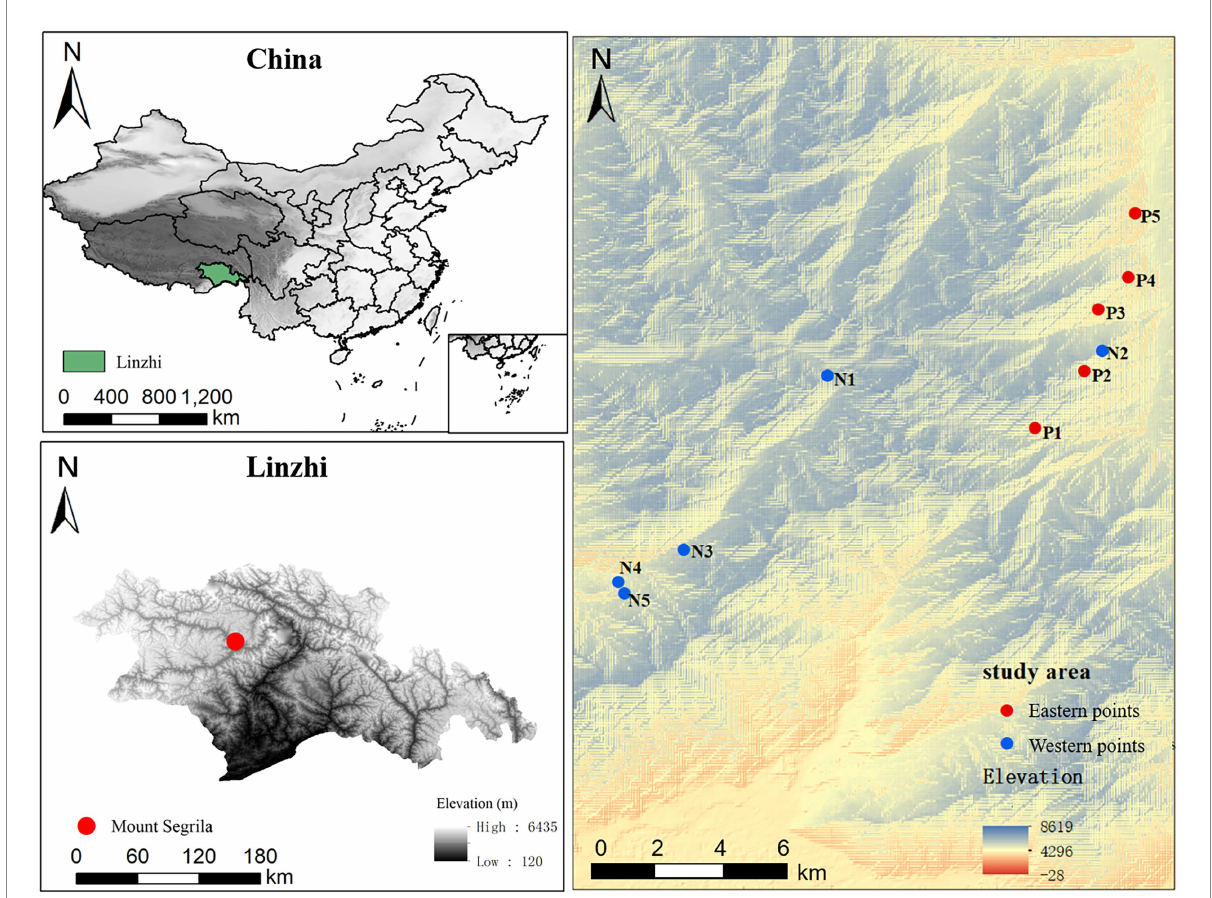
FIGURE 1 A map of the investigated area showing the locations of sampling sites along the altitudinal gradient on Mount Segrila, Tibet, China. P and N represent east slope and west slope, respectively. Different numbers mean different elevations (Number 1, 2, 3, 4, and 5 represent 4,300 m, 4,100 m, 3,900 m, 3,700 m, and 3,500 m,